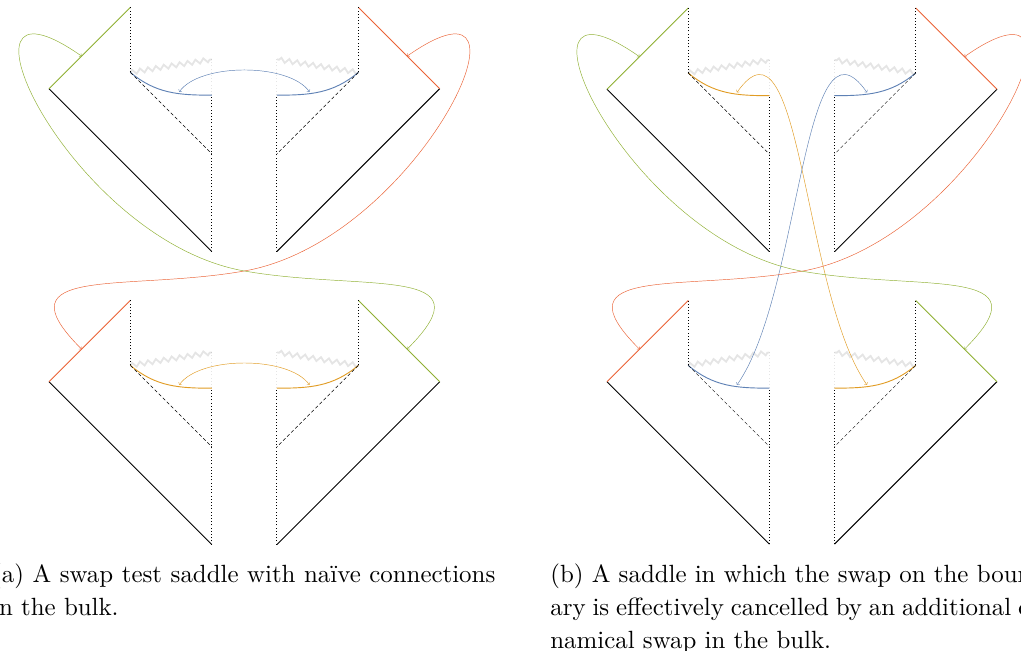
Figure 12. The two PS wormholes contributing to the path integral computing the expectation value of the swap operator, Tr( S ρ (2) )